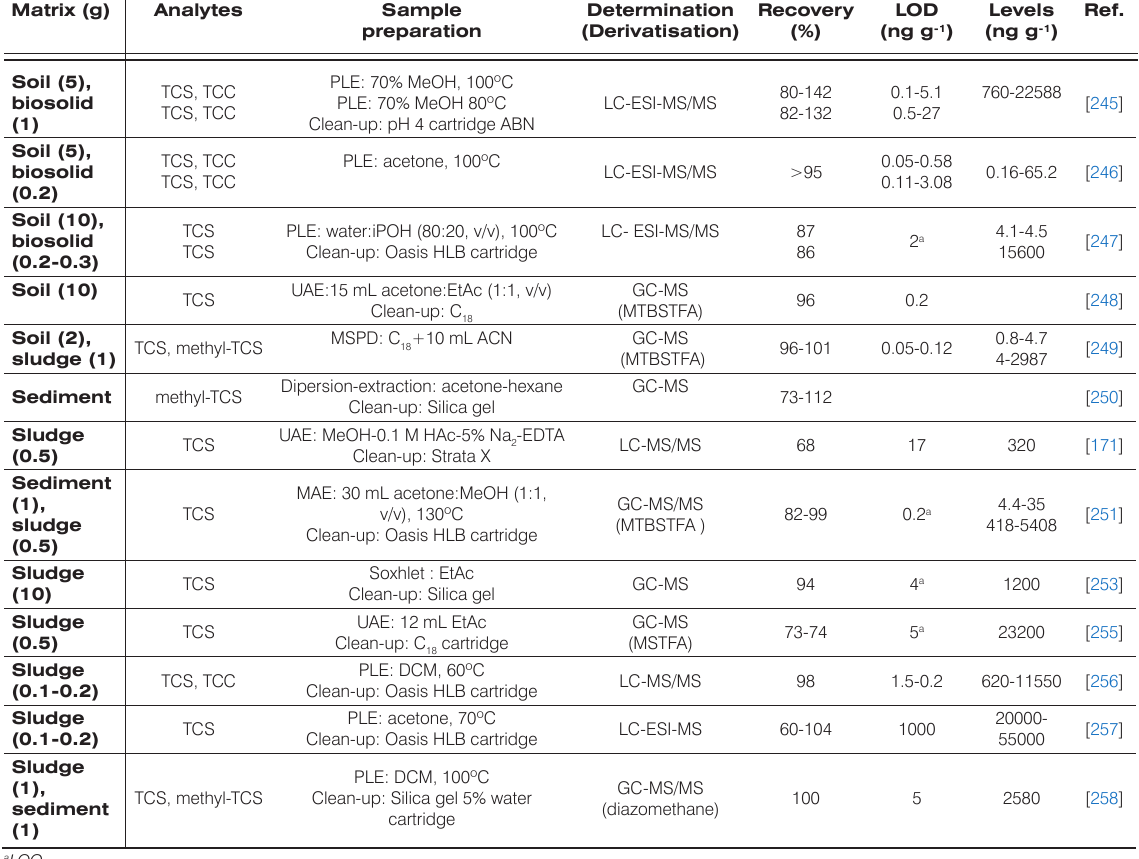
Table 11. Analysis of preservatives in environmental solid